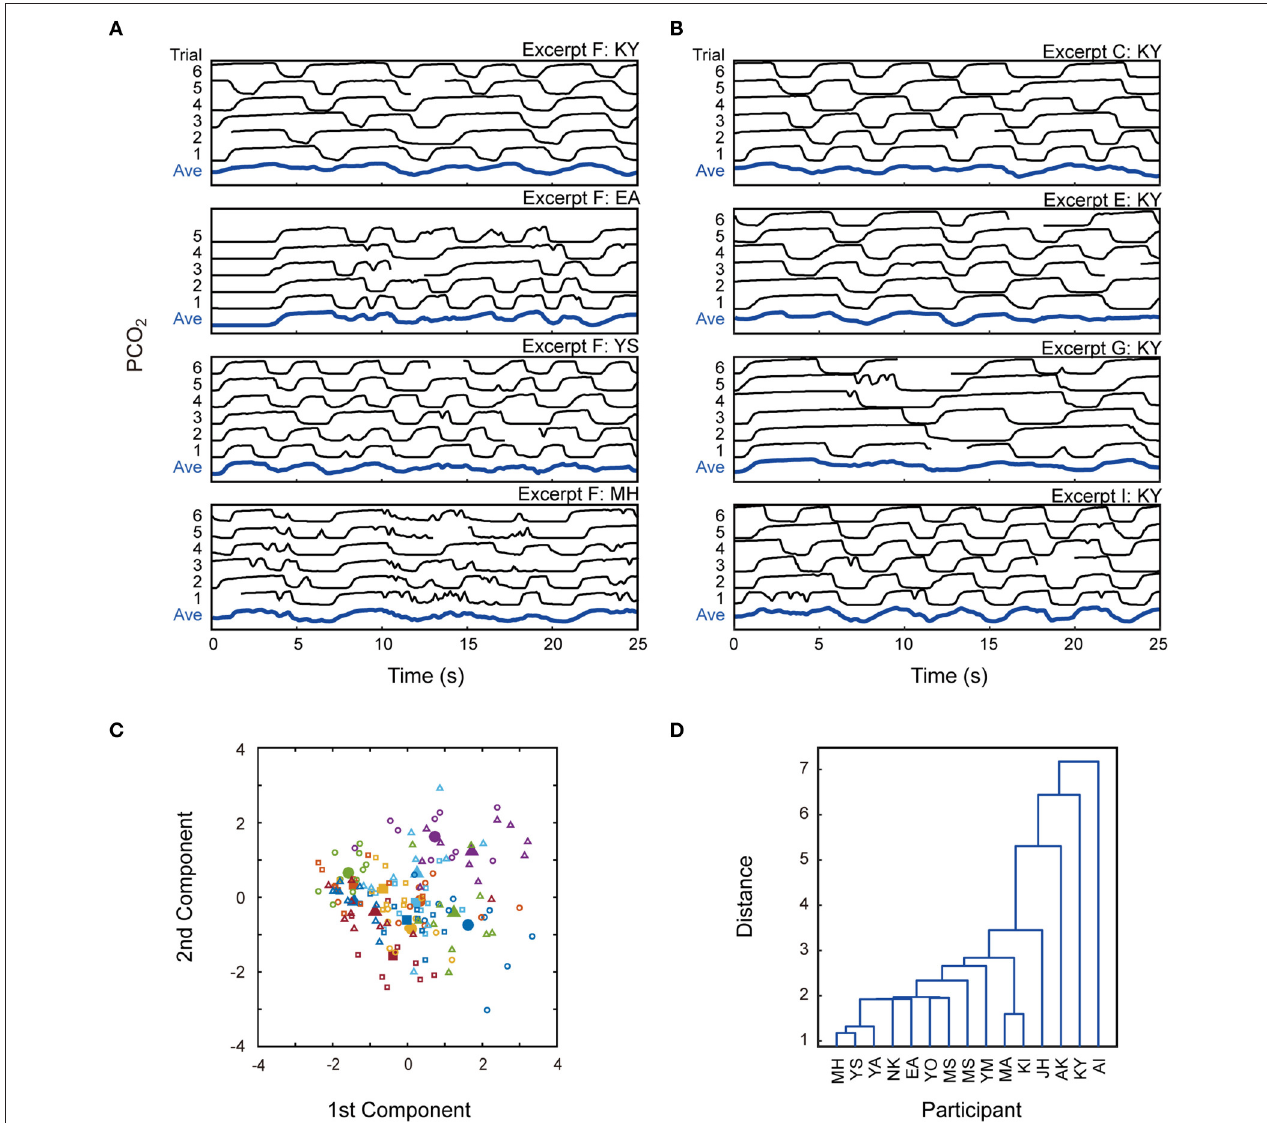
FIGURE 8 | Difference in breathing patterns between participants. (A) Breath patterns of the first 25s of Excerpt F for 4 participants are shown (result for another participant has been shown in Figure 3 ). Breathing pattern looks different between different pianists. (B) Breath patterns of one participant for Excerpt C, E, G and I are shown. These patterns generally look similar, suggesting that they shared features with each other. (C) Feature vectors of breathing patterns are plotted for each combination of the excerpts and participants (open symbols). The color of each symbol represents a participant. Filled symbols mean the inter-excerpt average feature vectors for individual participants. The same-colored symbols are distributed in a grouped manner, supporting that breathing patterns of individual pianists resembles between different music pieces. (D) Similarity of the respiratory pattern between the participants is shown by the dendrogram generated from the 5D feature